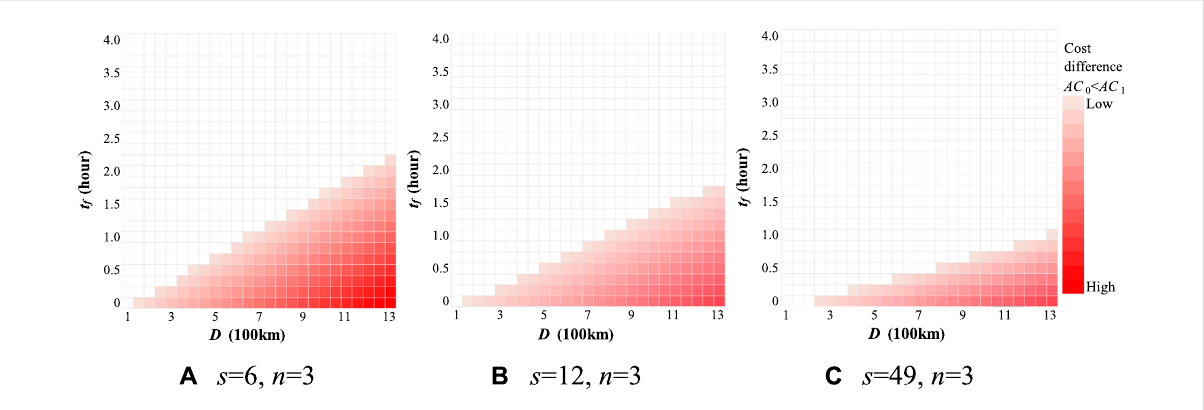
FIGURE 3 Cost comparison between Case 0 (single truck) and 1 (truck platooning) with changing inter-vehicle distance ( s ). (A) s = 6, n = 3 (B) s = 12, n = 3 (C) s = 49, n =